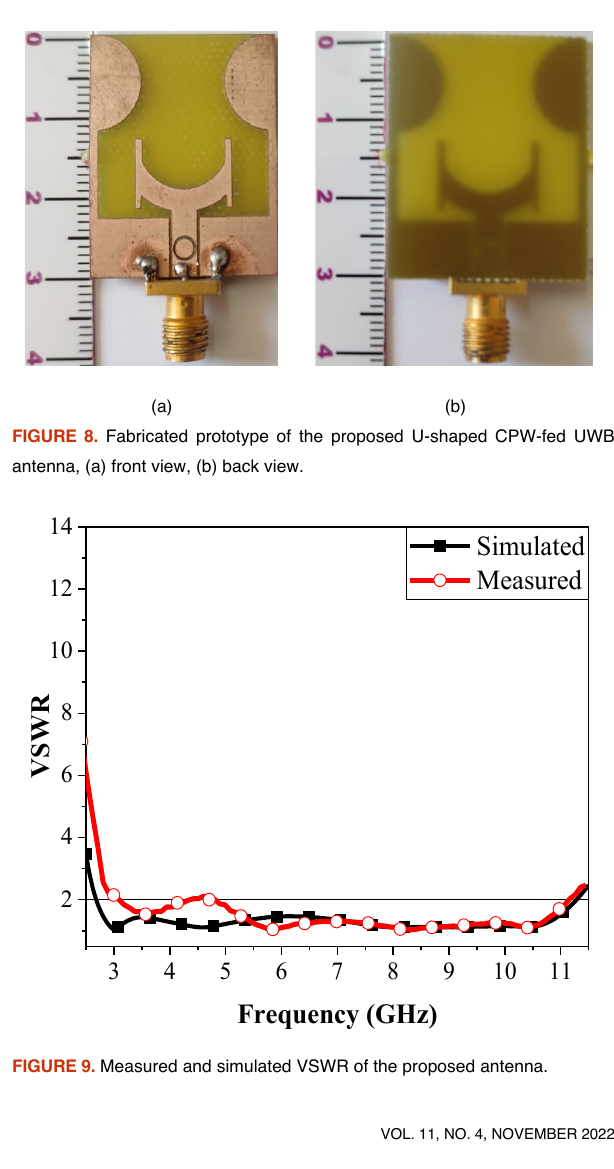
FIGURE 7. Current distribution on the antenna's surface at four frequencies (a) 3.6 GHz, (b) 5.77 GHz, (c) 8.33 GHz, and (d) 10.43 GHz.